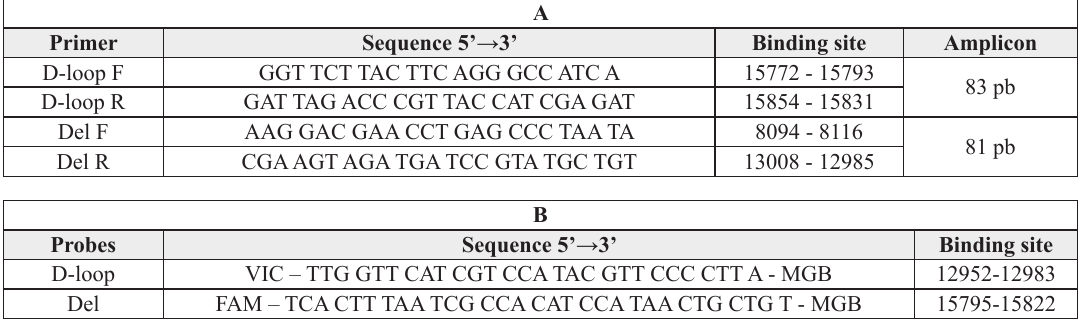
A. Primers used in real time PCR for amplification of a fragment of the D-loop mtDNA and a fragment indicative of the presence of the 4834 mtDNA deletion (Branda et al. 2002). B. Probes used in real time PCR for hybridization D-loop region and the region of occurrence of the 4834 mtDNA deletion (Branda et al.